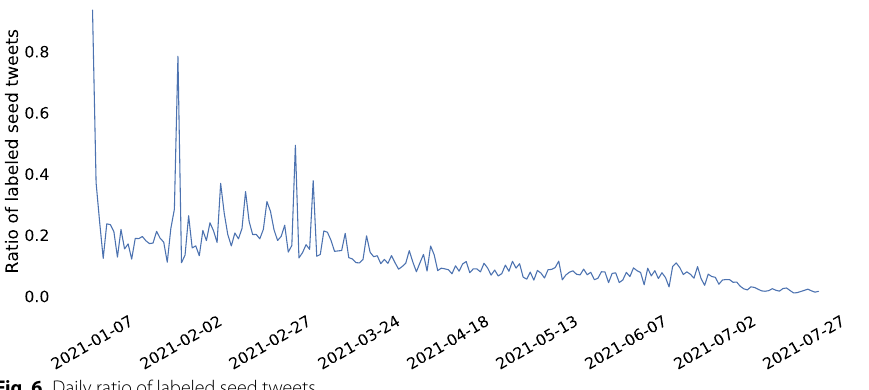
Fig. 6 Daily ratio of labeled seed tweets